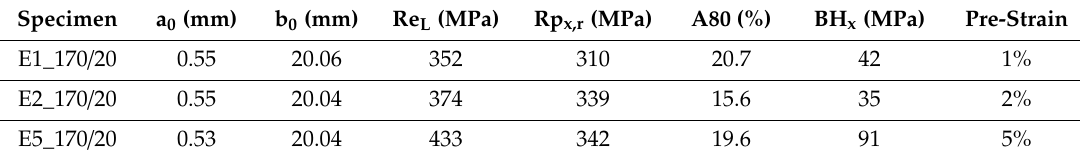
Table 3. Measured values of IF DX 51D, 170 ◦ C / 20 min.